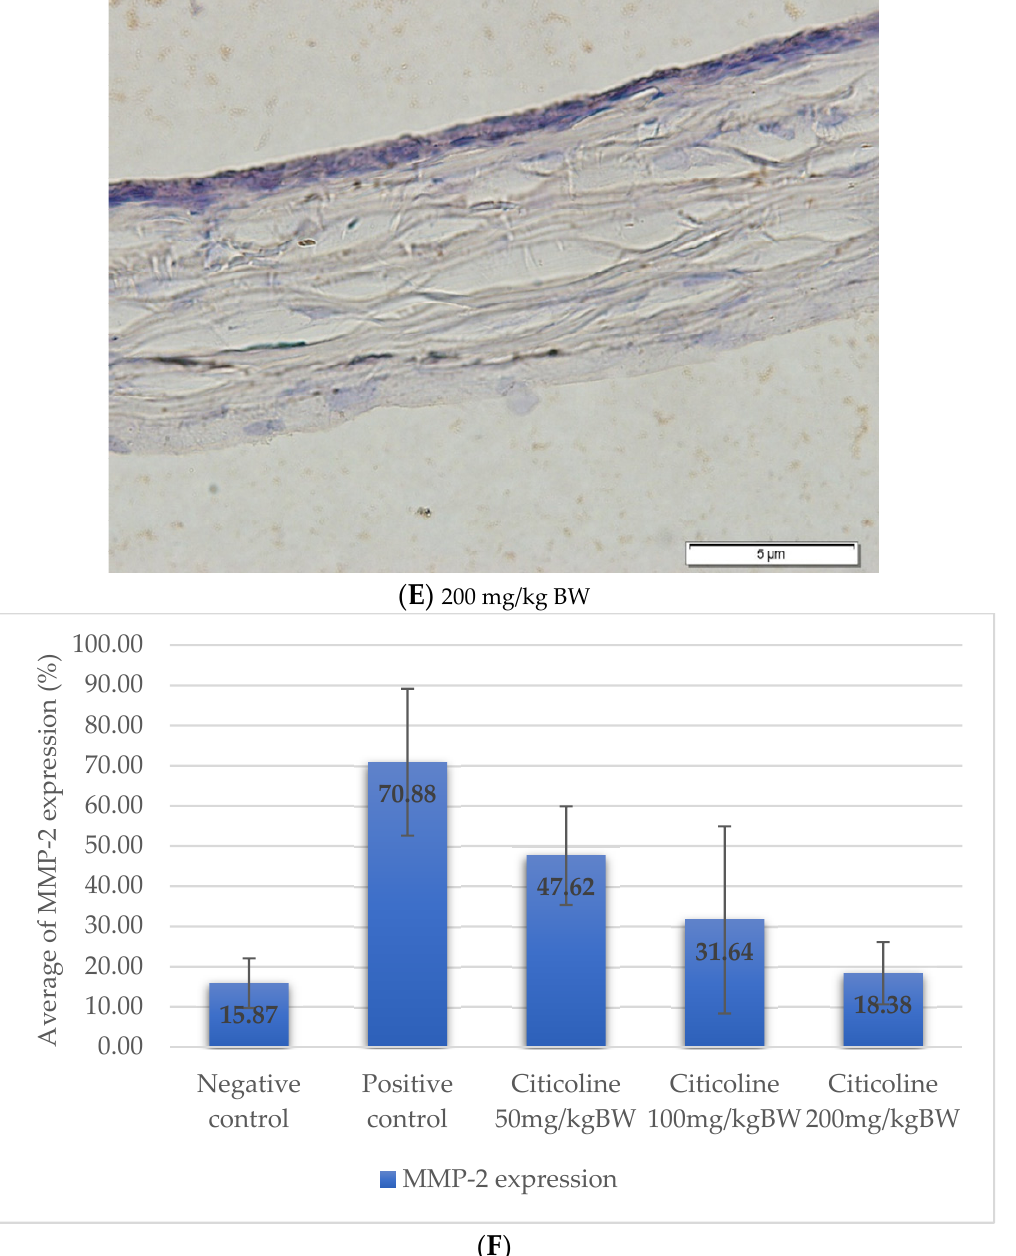
Figure 3. Rats’ Scleral Tissue after Antibody Anti-MMP-2 Staining (Left) ( A – E ). ( A ) Negative control group; ( B ) Positive control group; ( C ) Treatment groups with a citicoline dosage of 50 mg/kg BW; ( D ) 100 mg/kg BW; ( E ) 200 mg/kg BW; ( F ) The chart of mean MMP-2 expression in the scleral tissue. Based on Tukey test, the positive control group has the highest MMP-2 expression compared to the negative control group (70.88 ± 18.28 vs. 15.87 ± 6.17, p = 0.000), and treatment groups with a dose of 100 mg/kg BW (70.88 ± 18.28 vs. 31.64 ± 23.28, p = 0.004) and 200 mg/kg BW (70.88 ± 18.28 vs. 18.38 ± 7.75, p = 0.000).